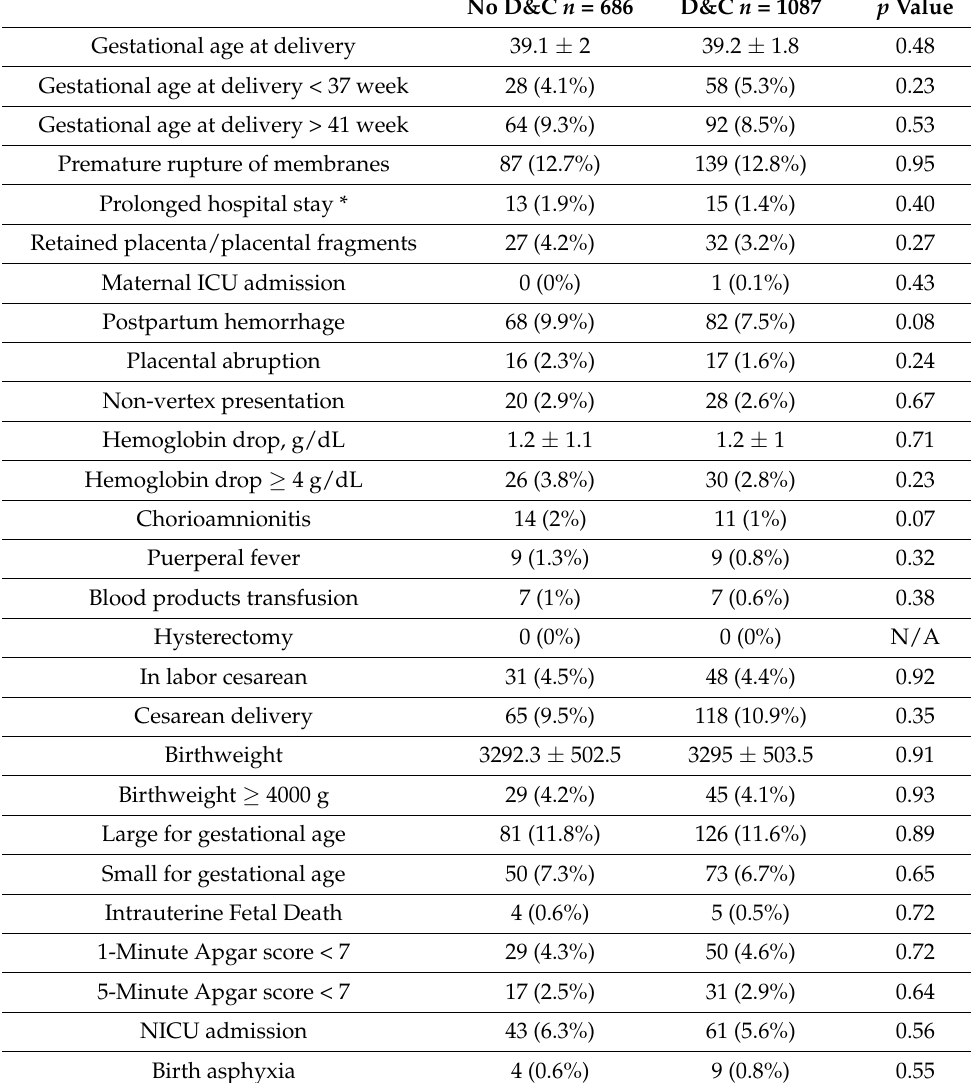
Table 2. Maternal and neonatal obstetrics outcomes among the study